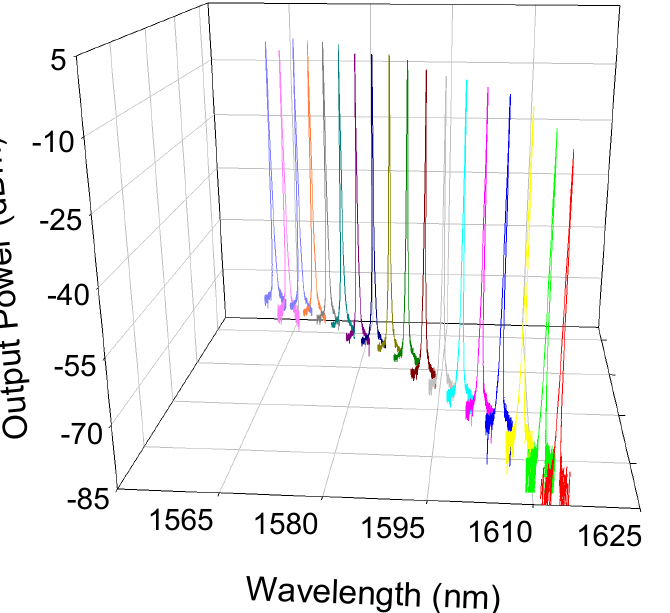
Figure 2. Observed output spectrum of each lasing lightwave of the EDF laser over the bandwidth of 1563.0 to 1613.0 nm.